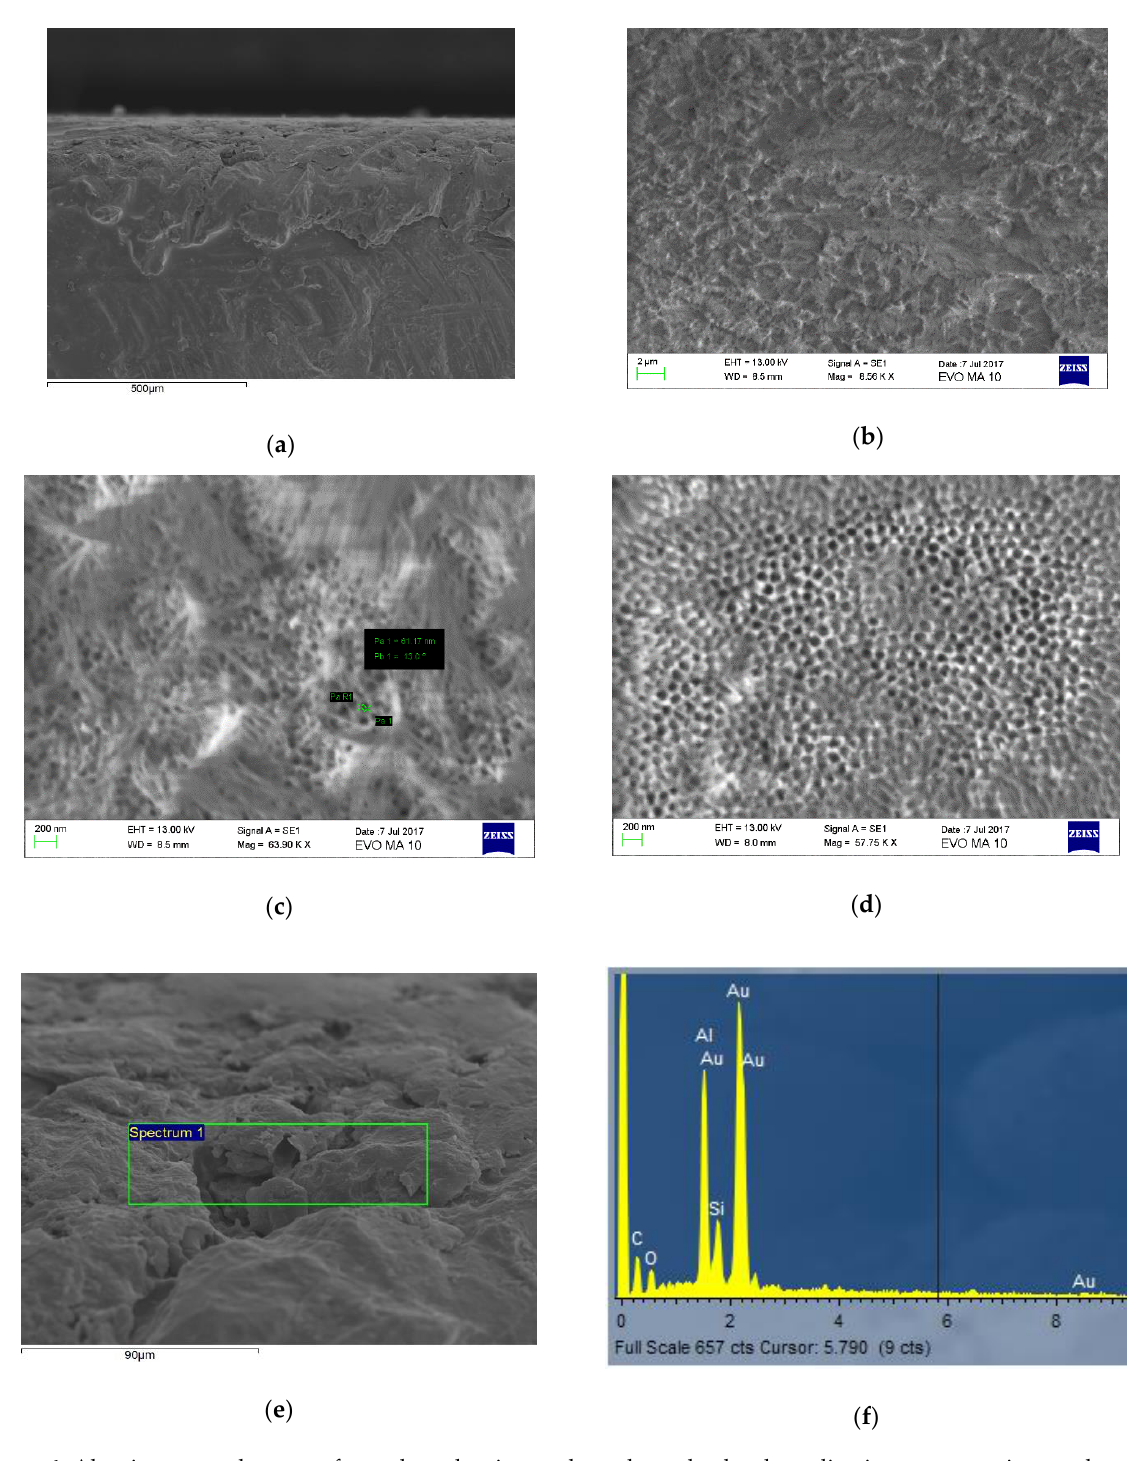
Figure 4. Alumina nanotubes were formed on aluminum plates through a hard anodization process using an electrolyte consisting of oxalic acid and ethylene glycol: ( a ) the alumina substrate formed after the first anodization step; ( b ) the alumina substrate formed after the second anodization step; ( c ) the alumina nanotubes before ultrasonication; ( d ) the alumina nanotubes after ultrasonication.; ( e ) the alumina nanotubes covered by epoxy resin and ( f ) elemental analysis of the sample — alumina nanotubes covered by the epoxy resin (65.52% Al 2 O 3 , 11.13%SiO 3 , 23.35% Fe 2 O 3 ).